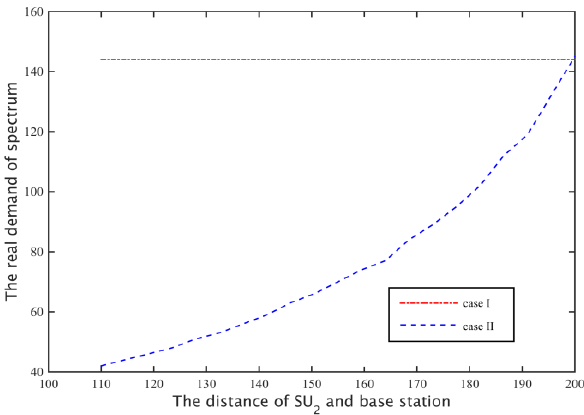
Figure 16. Spectrum requirements for secondary network of two cases.